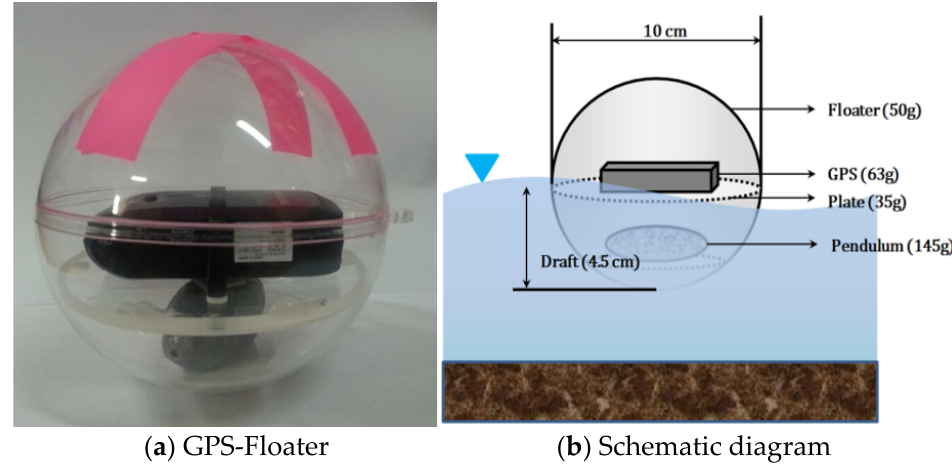
Figure 3. Schematic diagram of GPS drifter for velocity measurements .